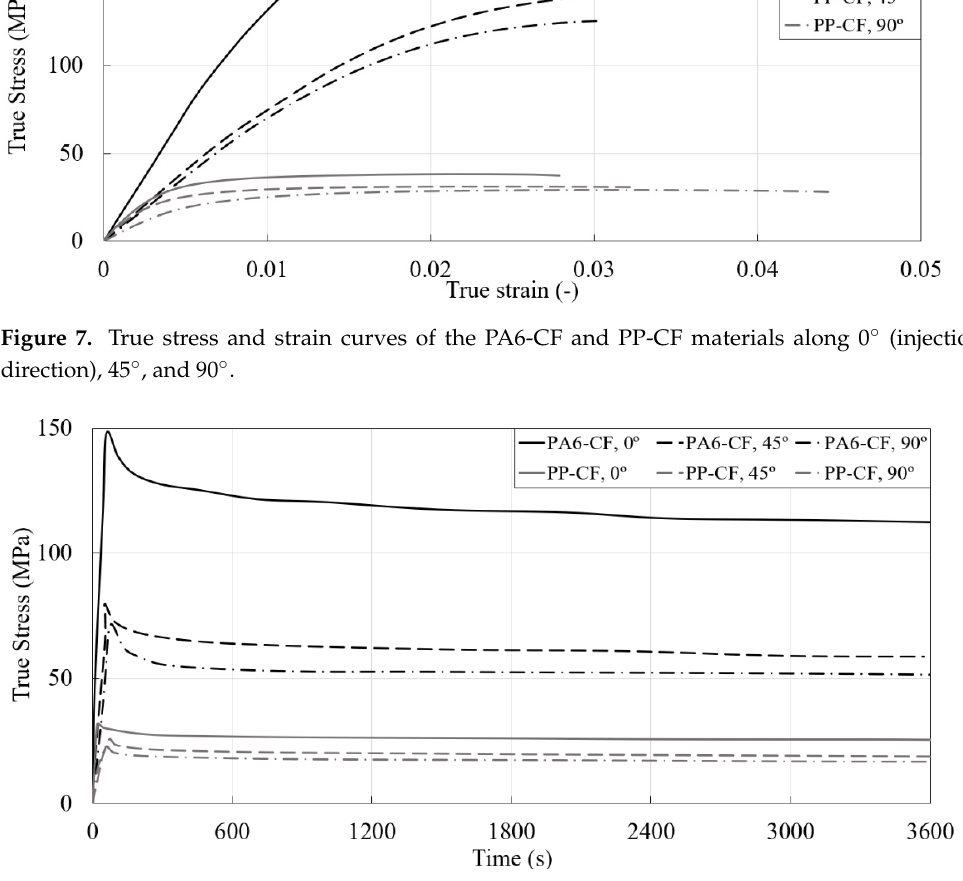
Figure 8. True stress–time curves of the PA6-CF and PP-CF obtained from the stress relaxation tests.